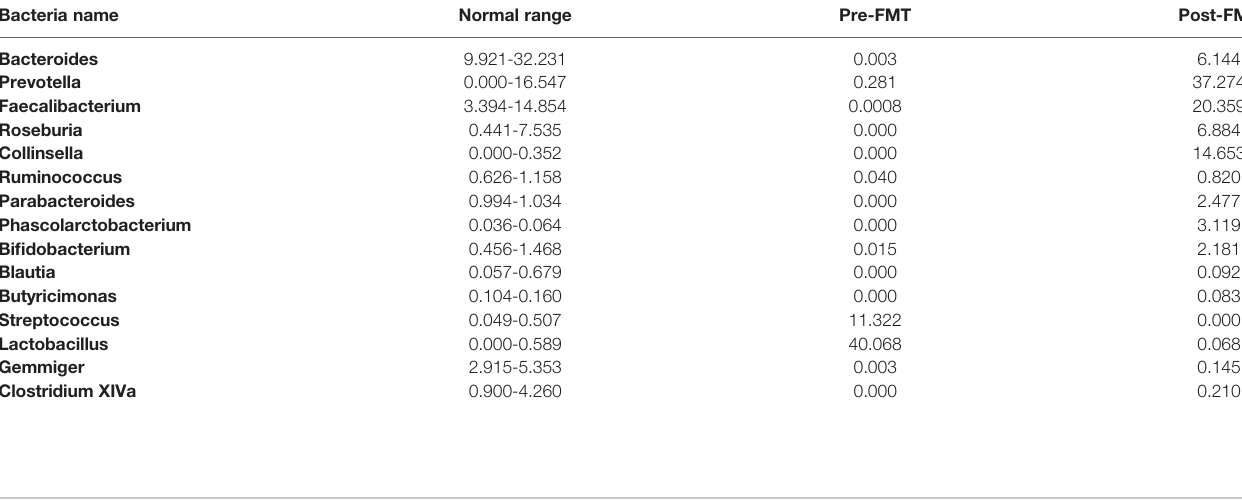
TABLE 3 | Change of abundance of various bacterial genera prior to and following FMT.